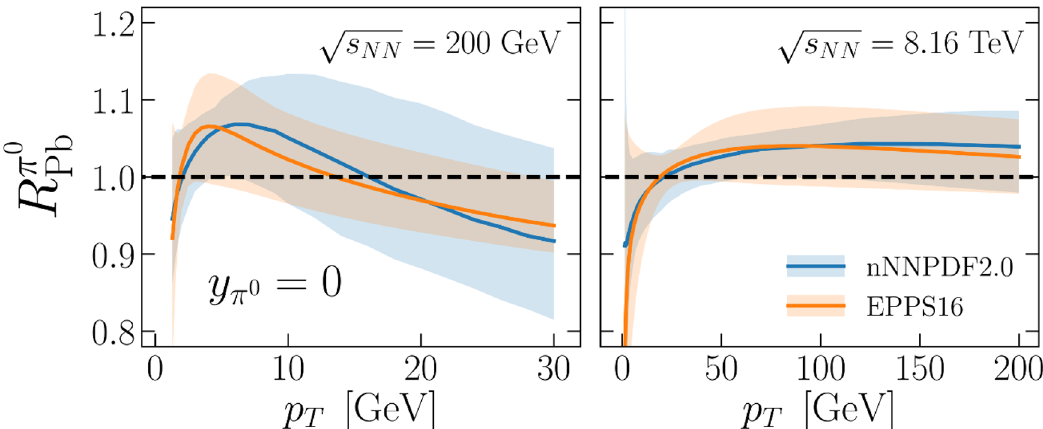
Figure 25 . The nuclear modi(cid:12)cation ratio R (cid:25) 0 for the production of neutral pions in proton-lead Pb collisions as a function of the pion transverse momentum p T . We provide theoretical predictions based on NLO QCD and the DSS14 hadron fragmentation functions both for nNNPDF2.0 and EPPS16, with the corresponding nPDF uncertainties in each case. Results are provided for the p RHIC kinematics (left), corresponding to s = 200 GeV, and for the LHC kinematics (right), p where s = 8 : 16 TeV, and in both cases pions are produced centrally, j y j = (cid:25) 0